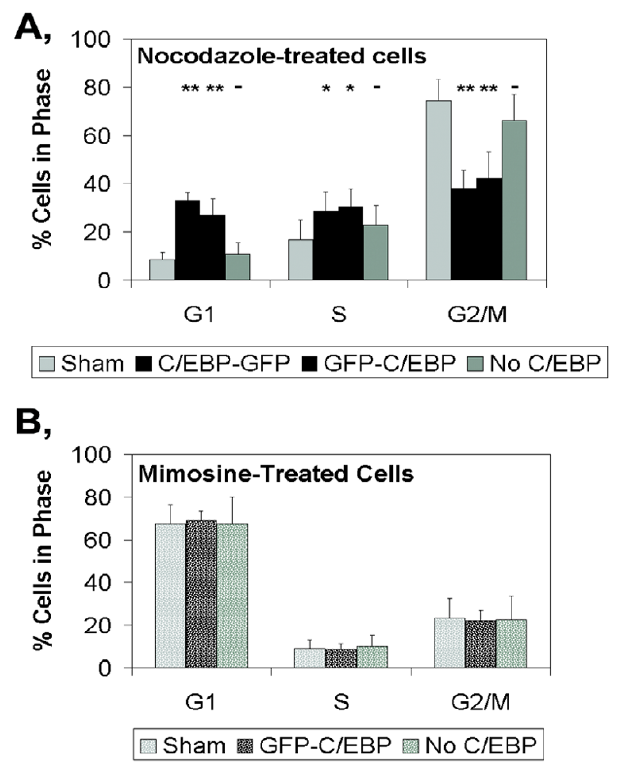
Figure 4 Cells were transfected with the control expression vector (Sham), the transcriptionally active C/EBP α -GFP expression vector or the transcriptionally inactive GFP-C/EBP α expres- sion vector and treated one day later with A, nocodazole or B, mimosine. Cells from the transfections with the C/EBP- GFP and GFP-C/EBP expression vectors were separated into cells with green fluorescence above background levels (C/ EBP-GFP and GFP-C/EBP) or at background (No C/EBP). The proportion of cells in the G1, S and G2/M phases were plotted as the mean +/- standard deviation from A, six or B, three independent experiments. Statistically significant differ- ences in the proportion of cells in G1, S or G2/M, relative to the proportions determined for the sham-transfected cells, are indicated (one-way ANOVA: ** , p < 0.01; * p < 0.05; -, no